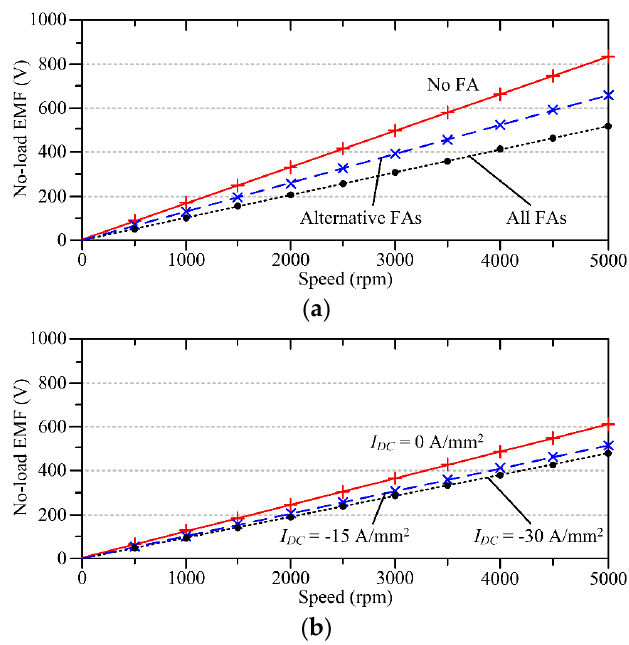
Figure 8. No-load electromotive forces (EMFs) at various speeds: ( a ) FA-PS-SFPM; ( b ) PS-SFDE.